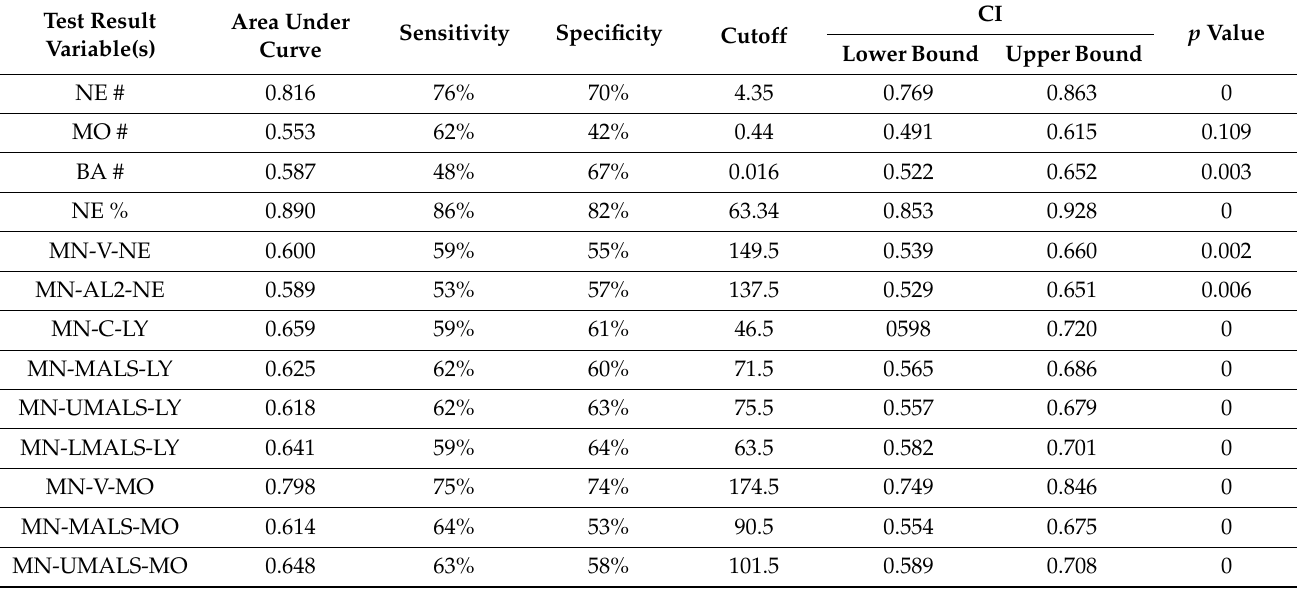
Table 2. Comparison of hematological parameters of COVID-19 patients and Healthy